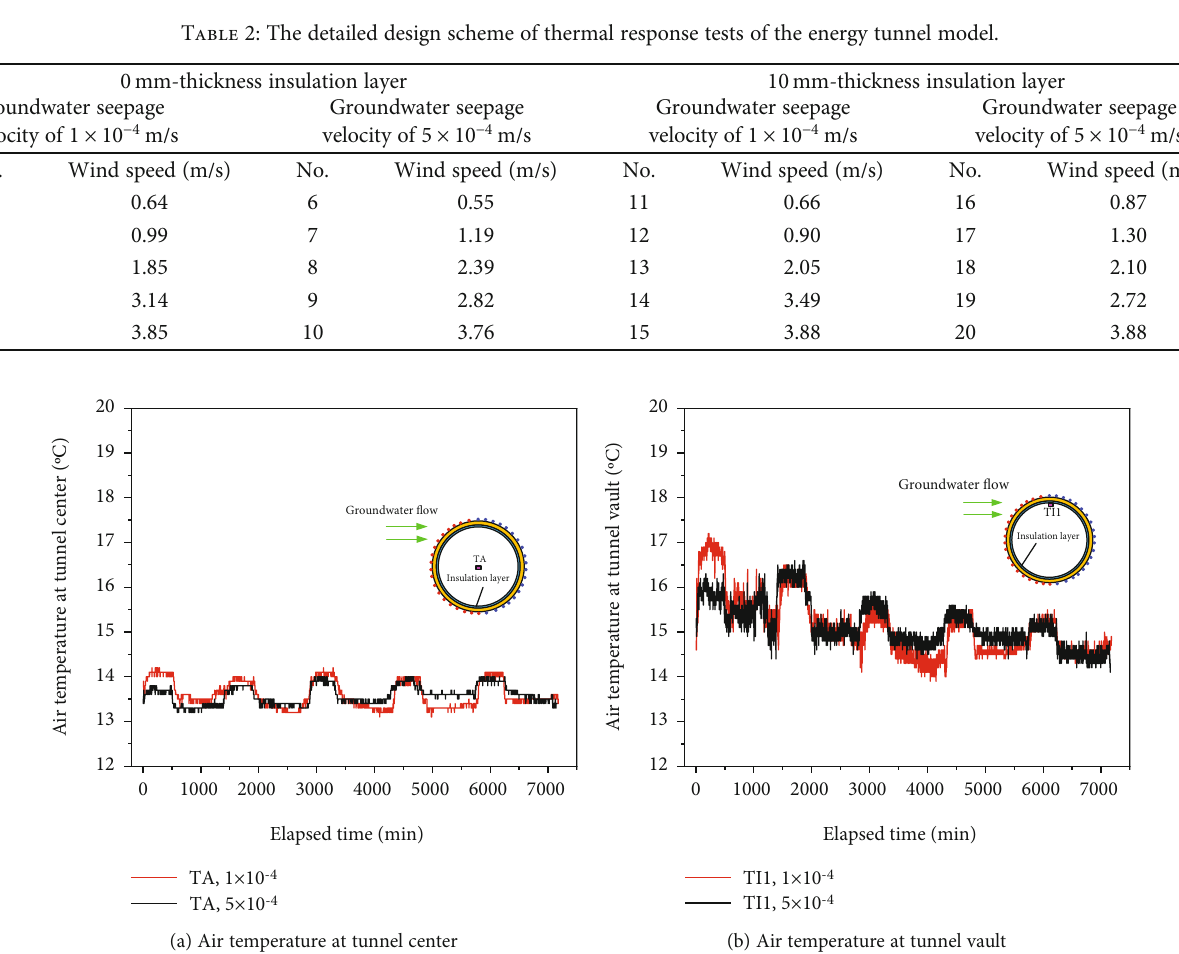
Figure 5: Temperature variation trend of air fl ow inside the energy tunnel at di ff erent